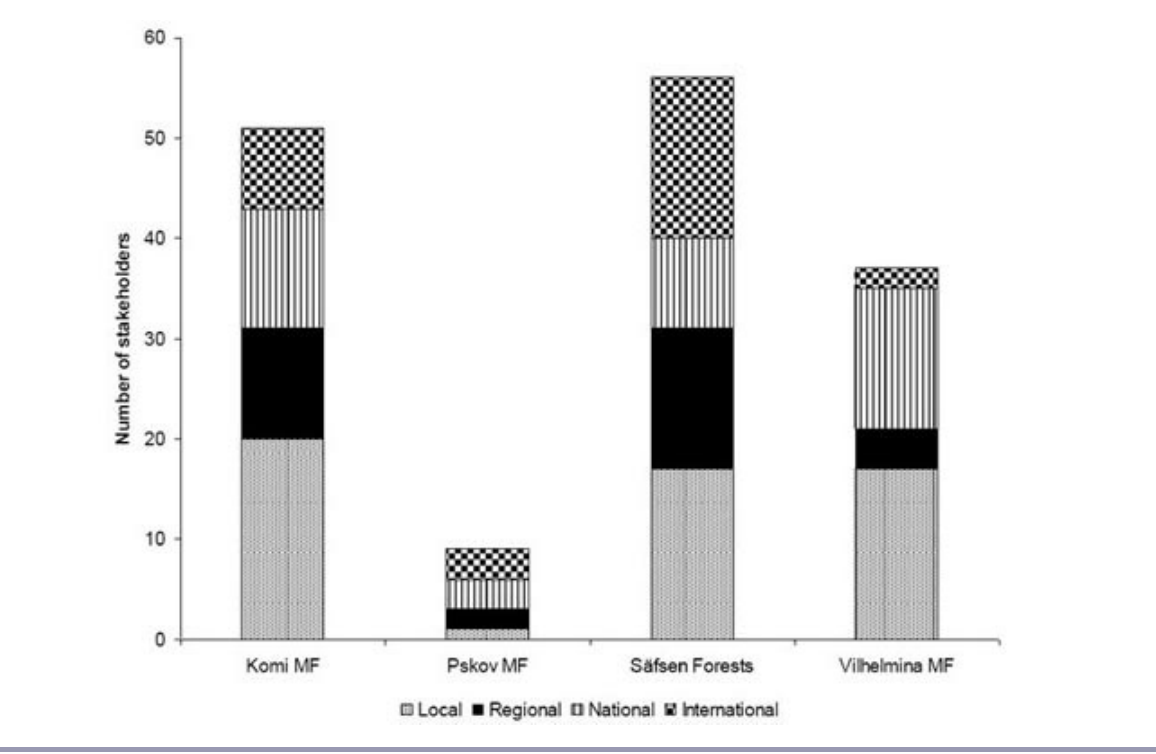
Fig. 3. Stakeholder distribution at different levels of organization (in a number of stakeholders in each MF) involved in the MFs’ development in NW Russia and